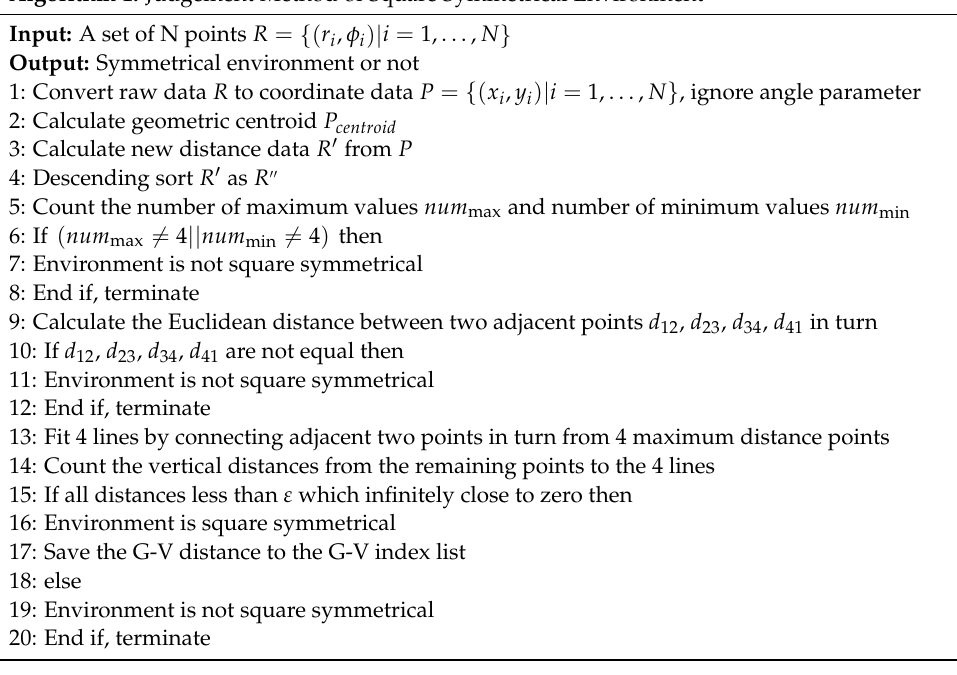
Algorithm 1. Judgement Method of Square Symmetrical Environment